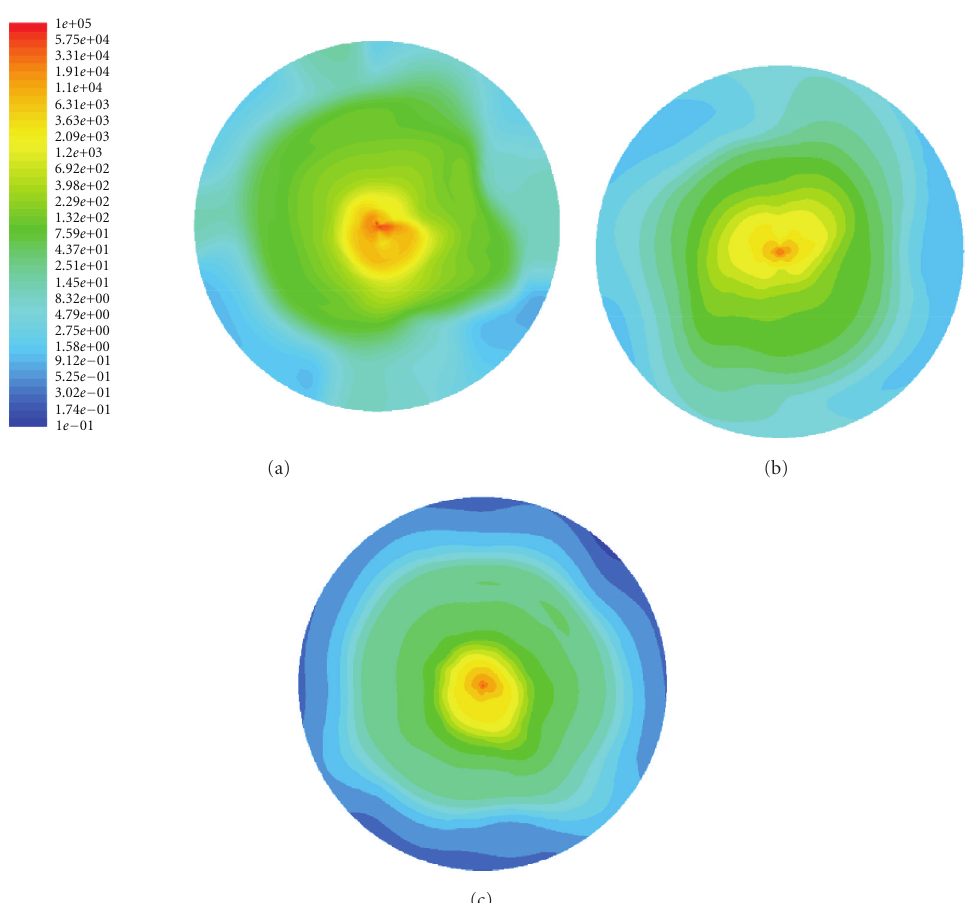
Figure 6: contour plot of turbulent dissipation rate ( ε ) inner region ( r = 0 to r = 0 . 01 m) [ z = 0 . 00075 m] [ D = 0 . 2 m]. Upper disk rotation speed = 1000 rpm, (a) 300mL/min, (b) 190mL/min, (c) 110